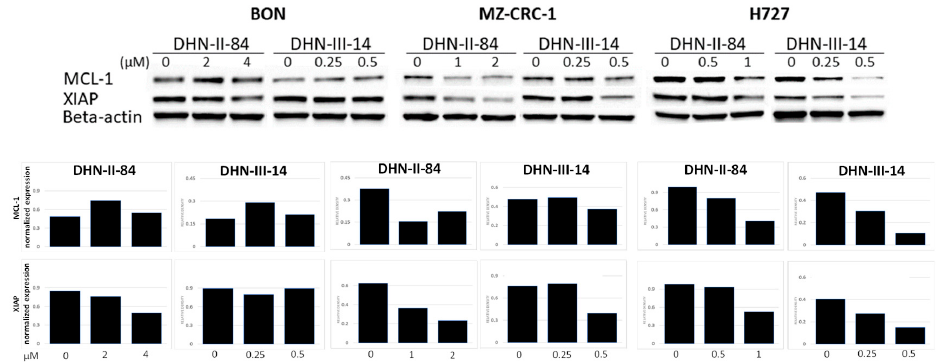
Figure 6. DHN-II-84 and DHN-III-14 decrease antiapoptotic markers in neuroendocrine cancer cells. Protein levels of MCL-1 and XIAP were evaluated by Western blotting after 48 h of treatment. MCL-1, myeloid cell leukemia-1; XIAP, X-linked inhibitor of apoptosis protein. Both antiapoptotic markers decreased in MZ-CRC-1 and H727 cell lines. Only DHN-II-84 treatment in BON cell line decreased XIAP. Densitometry graphs of MCL-1 and XIAP protein levels normalized to beta-actin band intensity levels. Relative density levels shown after